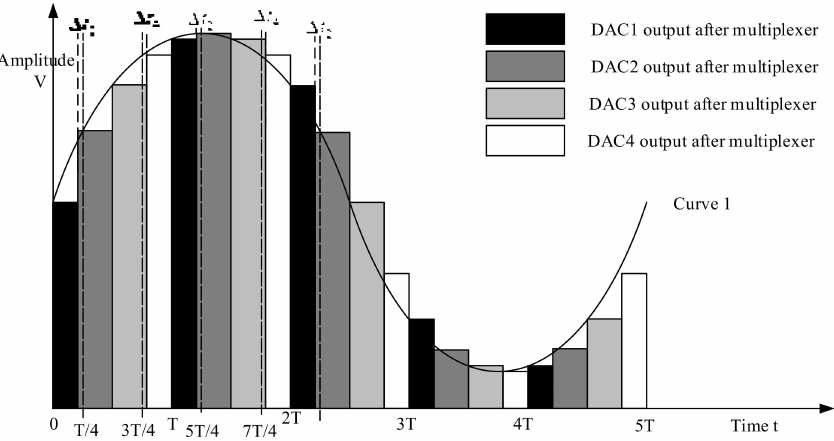
Figure 9. The output waveform after channel switching when the time error